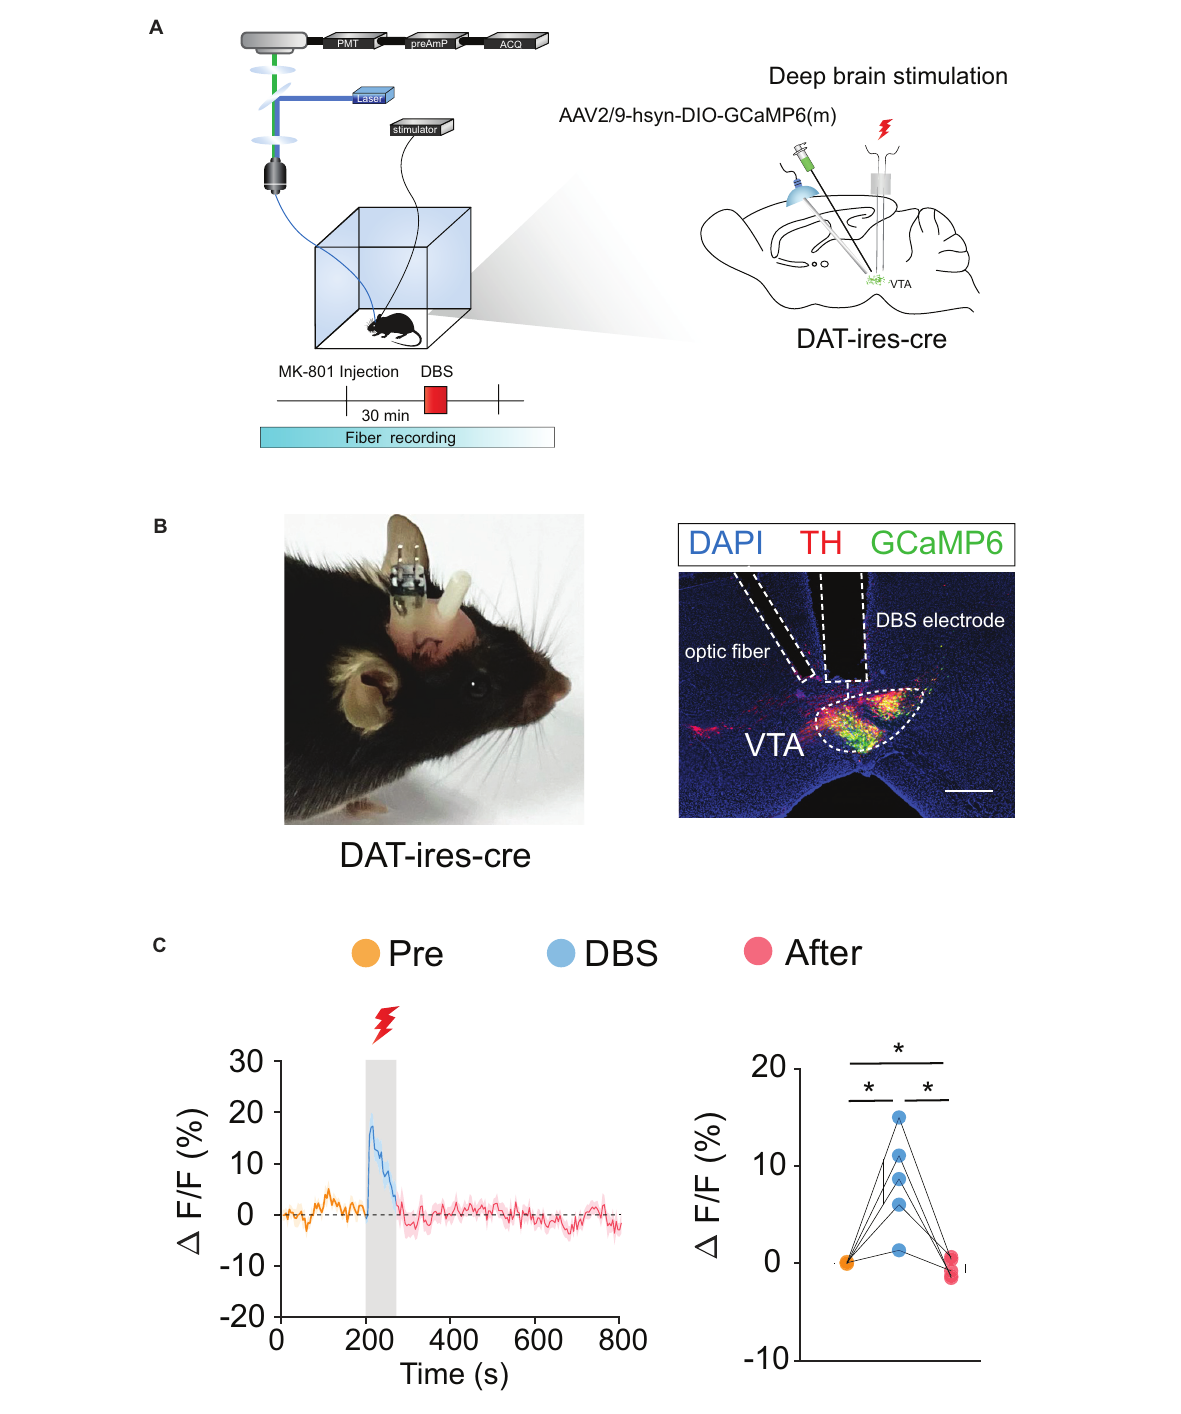
FIGURE3 DBS of the VTA activates VTA DA neurons. (A) Left: schematic of the DBS equipment and the fiber photometry system. Right: schematic of viral injection, fiber implantation, and DBS electrode implantation in DAT-ires-cre mice. (B) Left: actual view of the electrode and the fiber on the head of a DAT-ires-cre mouse. Right: successful expression of GCaMP6m in VTA DA neurons. White dashed lines indicate the location of the DBS electrode and fiber above the VTA. The image shows GCaMP6m+ cell bodies (green) and TH+ neurons (red) in DAT-ires-cre mice. Scale bar, 300 µ m. TH, tyrosine hydroxylase. (C) GCaMP6m signals from VTA DA neurons show that DBS of the VTA activates VTA DA neurons. * p < 0.05, one-way ANOVA. All error bars represent ± SEM. n = 5